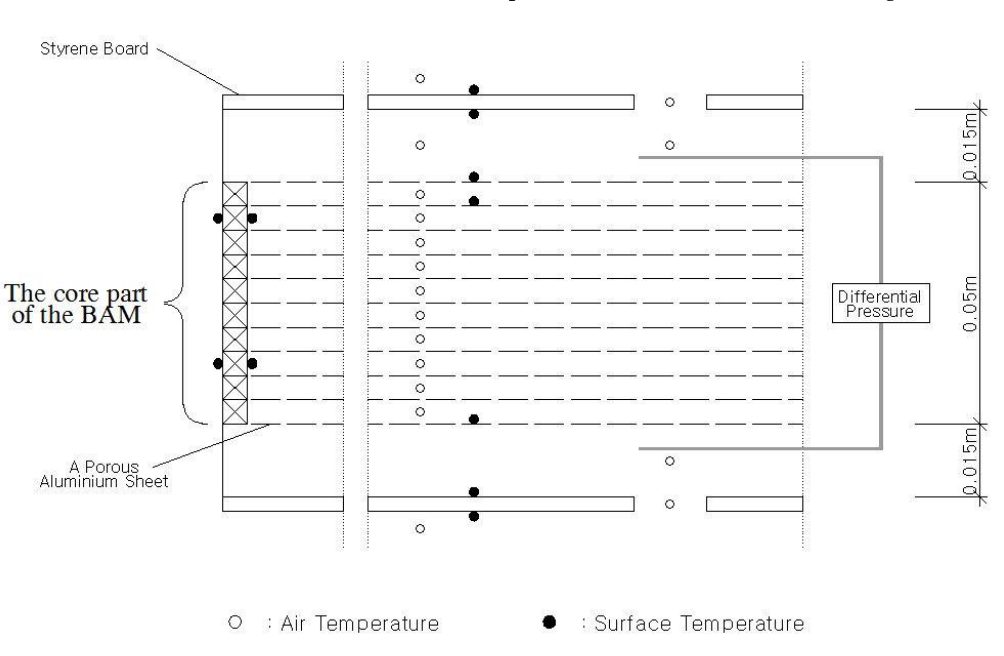
Figure 5. Measurement parts and items.